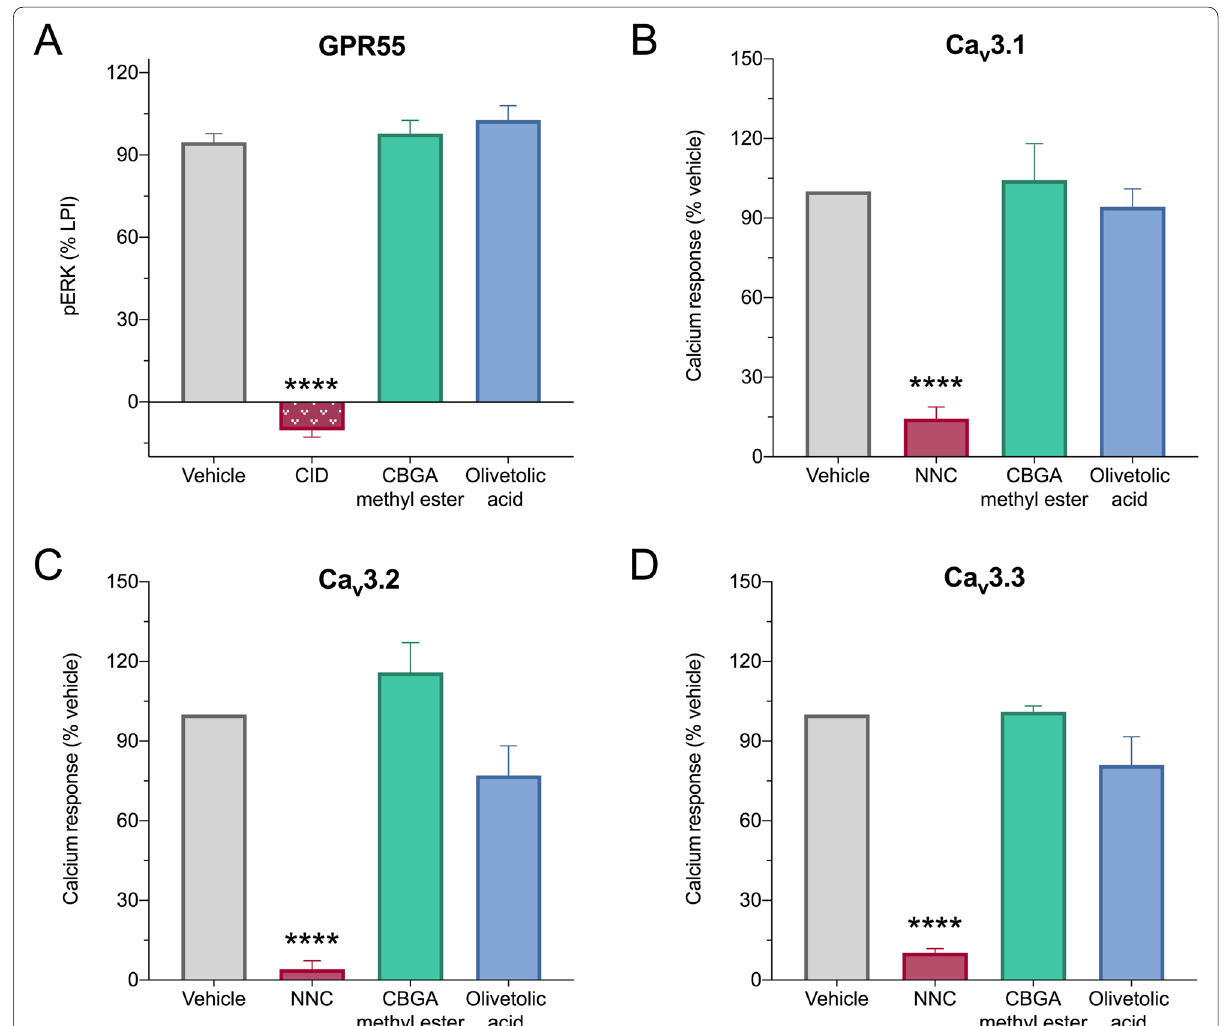
Fig. 3 CBGA methyl ester and olivetolic acid do not inhibit GPR55 or T‑type calcium channels. A HEK293 cells expressing human GPR55 were used to screen compounds for antagonist activity. ERK phosphorylation (pERK) following treatment with EC 80 concentrations of the endogenous ligand LPI was determined by Alphascreen Phospho‑ERK1/2 assay and used as a measure of GPR55 activation. Compounds were screened at a concentration of 10 μM (CID, CID16020046). Data are expressed as a mean SEM, with n 5 per group (**** p < 0.0001, one‑way ANOVA followed ± = by Dunnett’s post hoc). HEK293 cells expressing human B Ca v 3.1, C Ca v 3.2, or D Ca v 3.3 were used to screen compounds for antagonist activity. Changes in intracellular calcium concentrations were used as a measure of calcium channel activity. Compounds were screened at a concentration of 10 μM (NNC, NNC 55‑0396). Data are expressed as a mean SEM, with n 5 per group (**** p < 0.0001, one‑way ANOVA followed by Dunnett’s ± = post